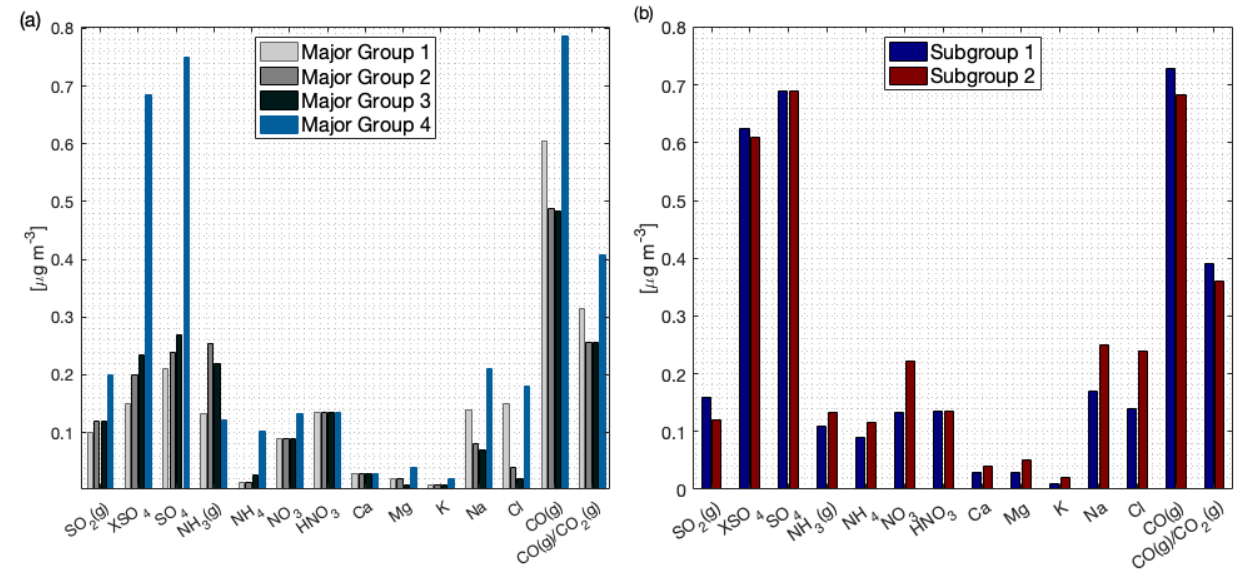
Figure A2. Median concentration of major species in particle and gas phase for ( a ) the four major groups and ( b ) the two subgroups of major group 4. CO is displayed in units of ppbv/200 and the ratio CO(g)/CO 2 (g) in ppbv/ppmv, all other species in µ gm − 3 .